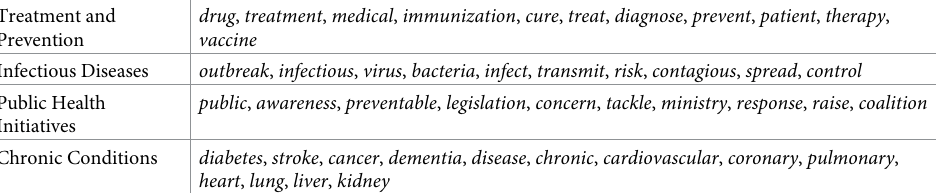
Table 1. Pre-pandemic topics and